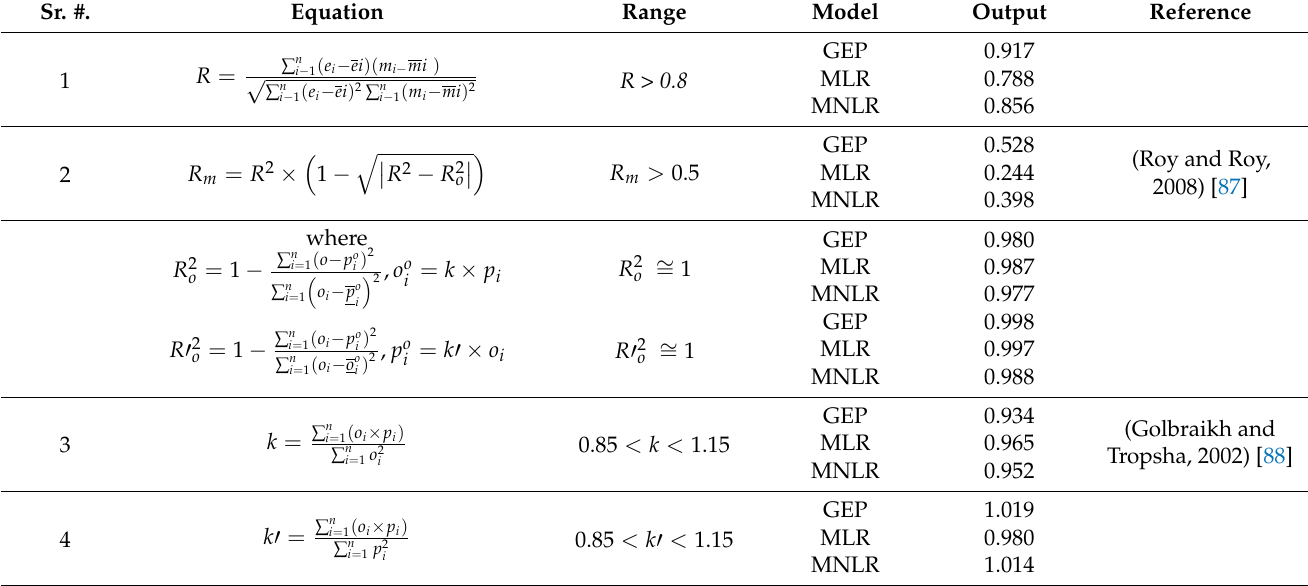
Table 2. External validation assessment of AI and Regression